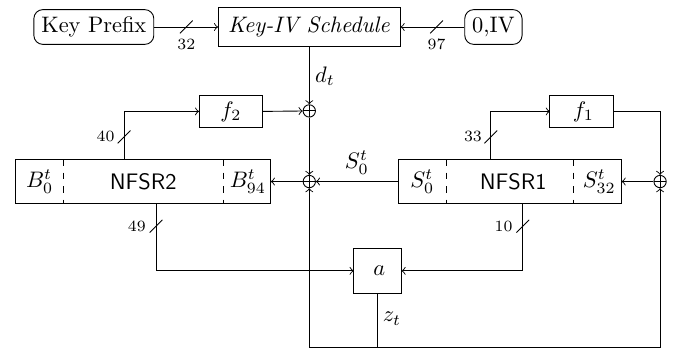
Figure 2: Draco in phase 2 of the state